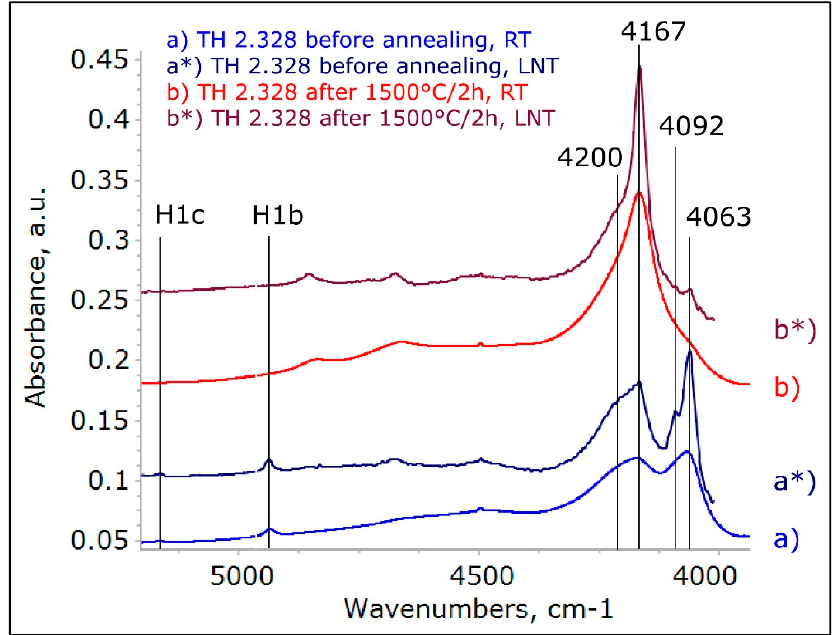
Figure 10. The NIR spectra (at 77 K) of a diamond exhibiting both the DAC (4167/4063 cm − 1 ) as well as H1b/H1c before (a/a*) and after annealing to 1500 °C for 2h (b/b*). It is obvious that the 4063/4092 cm − 1 component is annealed out while the 4167 cm − 1 ZPL increases distinctly after the annealing experiment. H1b and H1c are also annealed out under these conditions. The 4200 cm − 1 band is apparently unaffected. The spectra were shifted vertically for clarity.